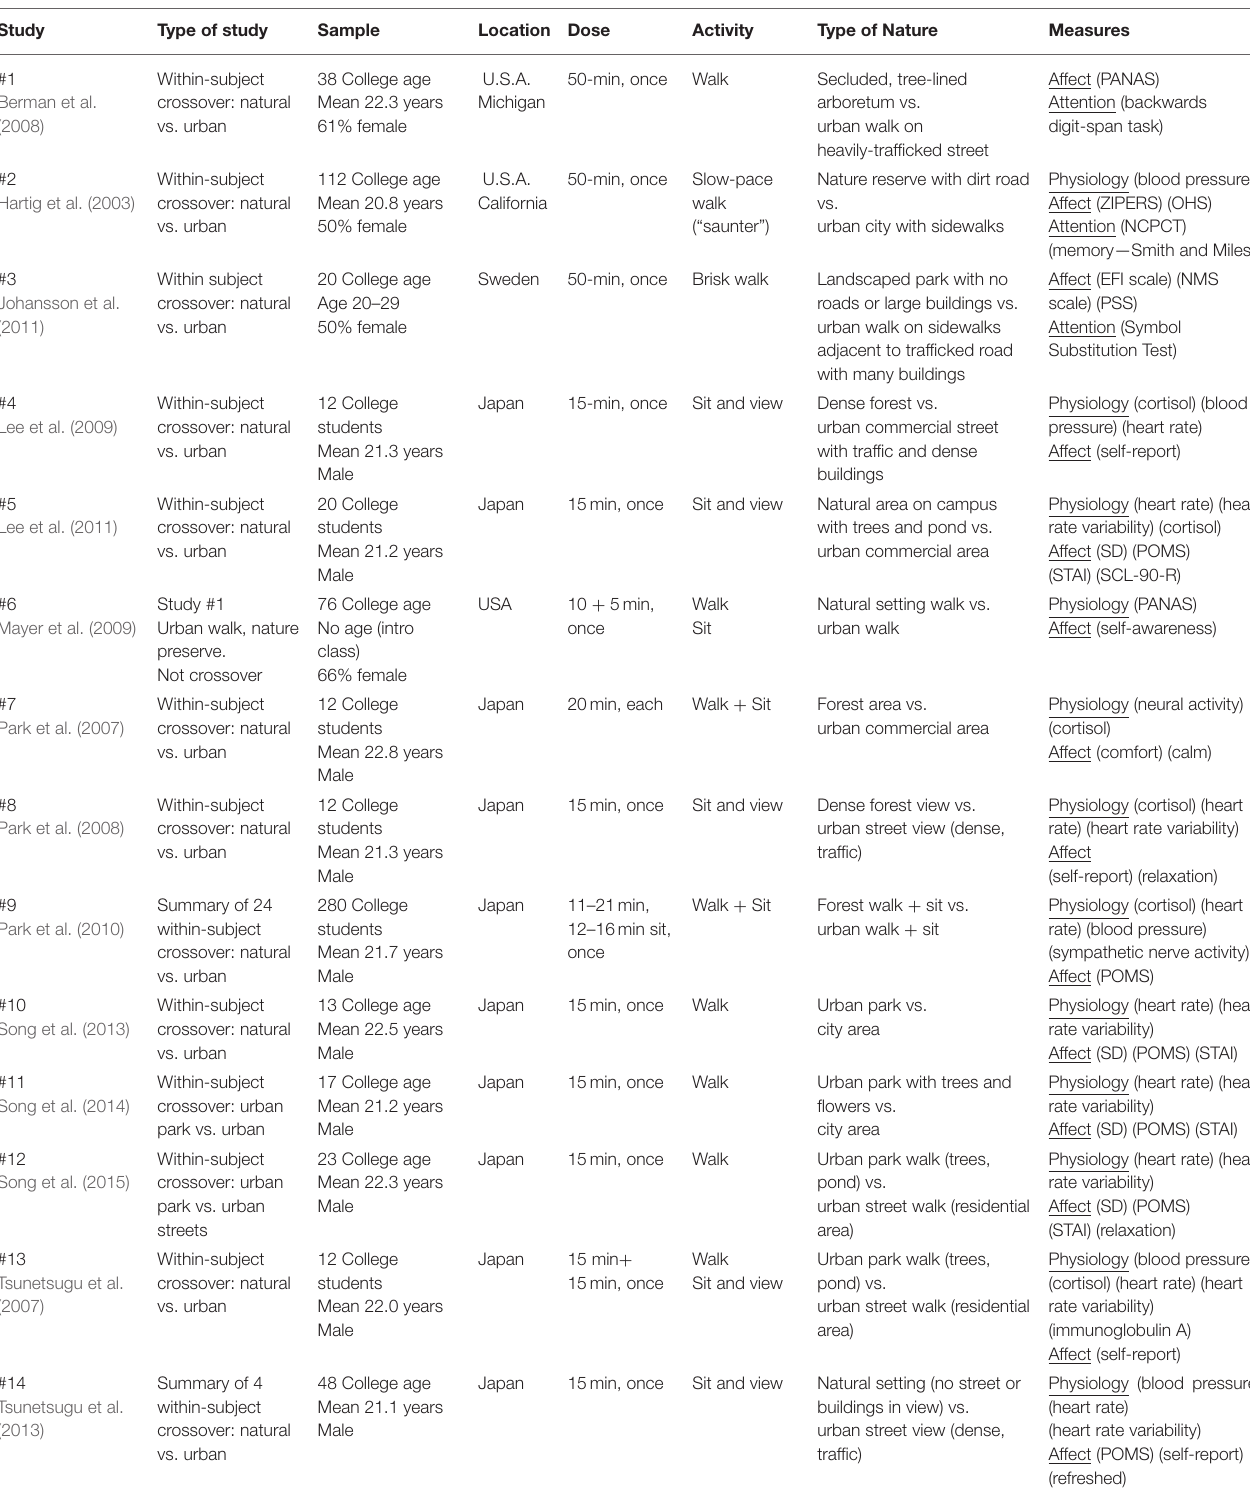
TABLE 1 | Characteristics of included